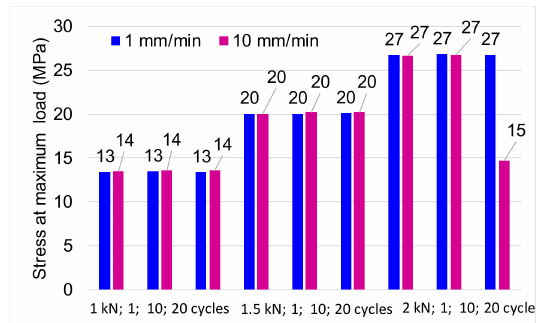
Figure 7. Variation of stresses at maximum